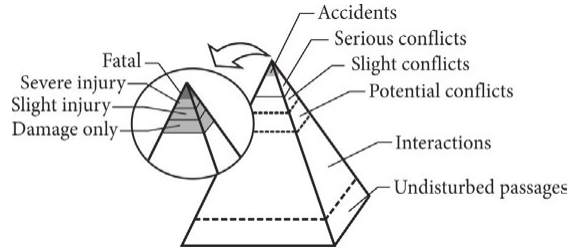
Fig 4. Safety Pyramid , adopted from Hydén